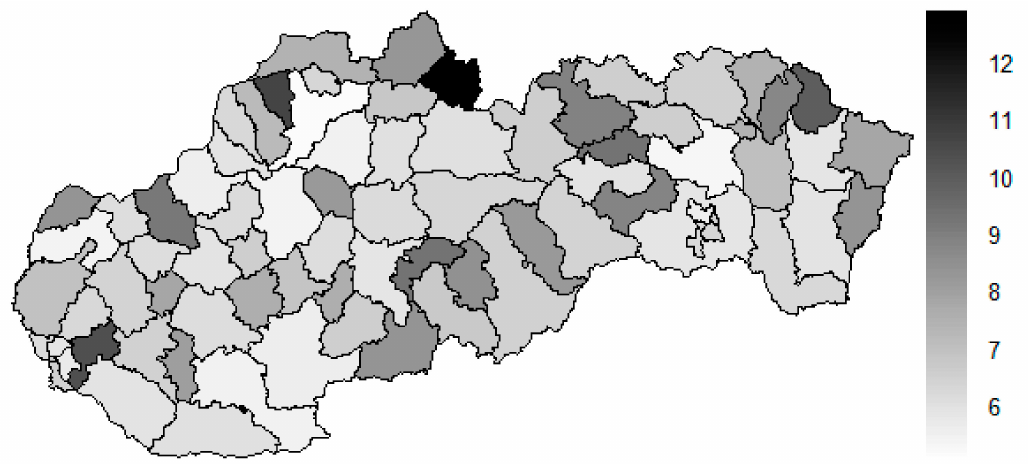
Figure 28. Preventable mortality similarity map of the districts for the male sex in the year 2008. Source: own elaboration by the